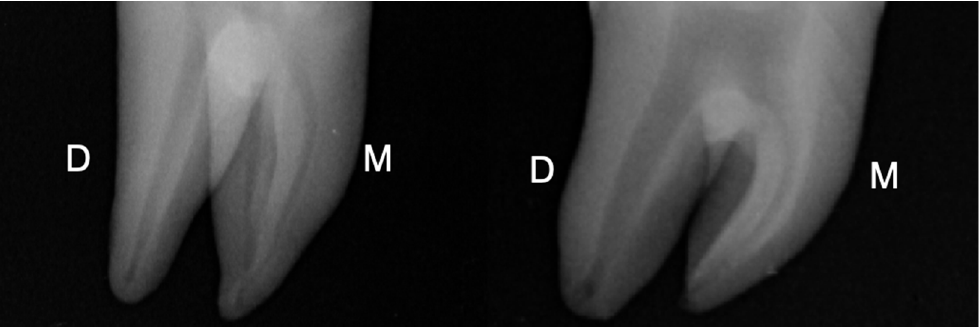
Figure 1. Periapical radiographs of two mandibular molars selected for the study. D: distal, M: me ‐ sial.